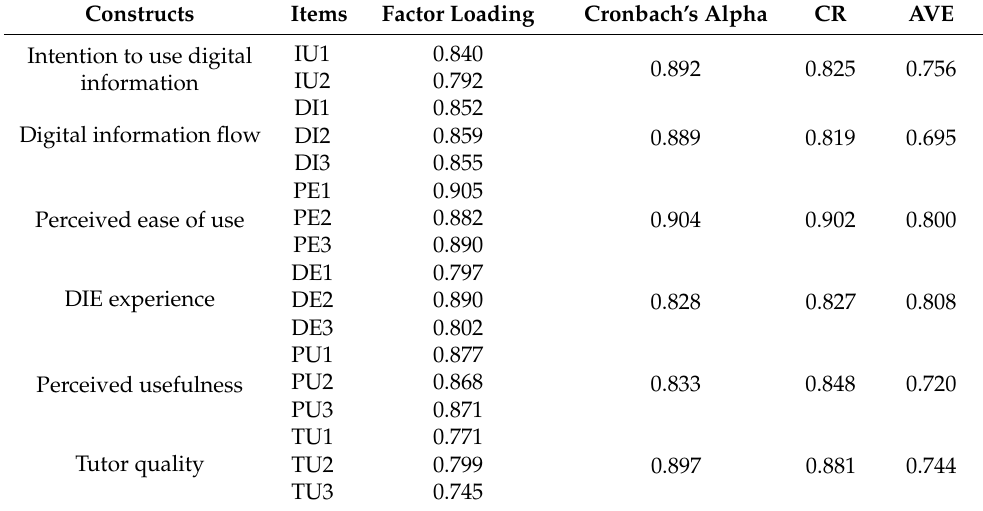
Table 4. Convergent validity